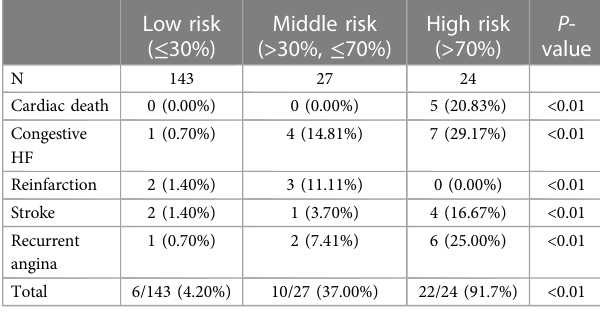
TABLE 4 Distribution of MACE in different levels of risk at 6-month